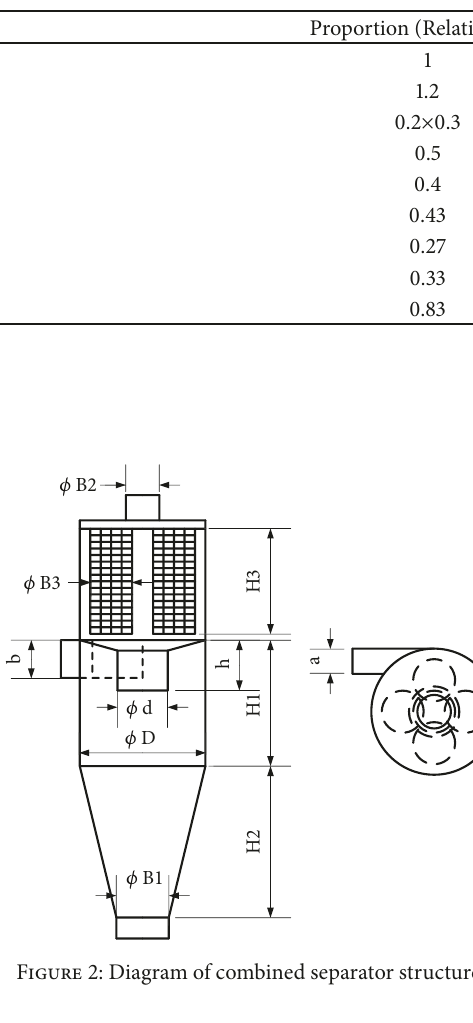
Table 1: Initial basic parameters of the combined separator.